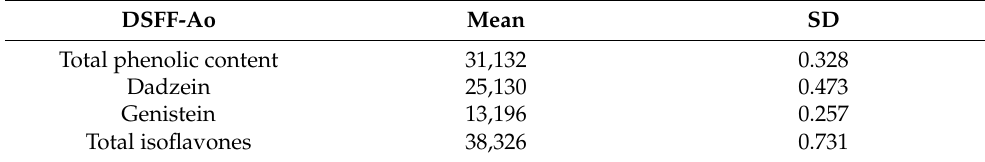
Table 3. DSFF-Ao total phenolic content.